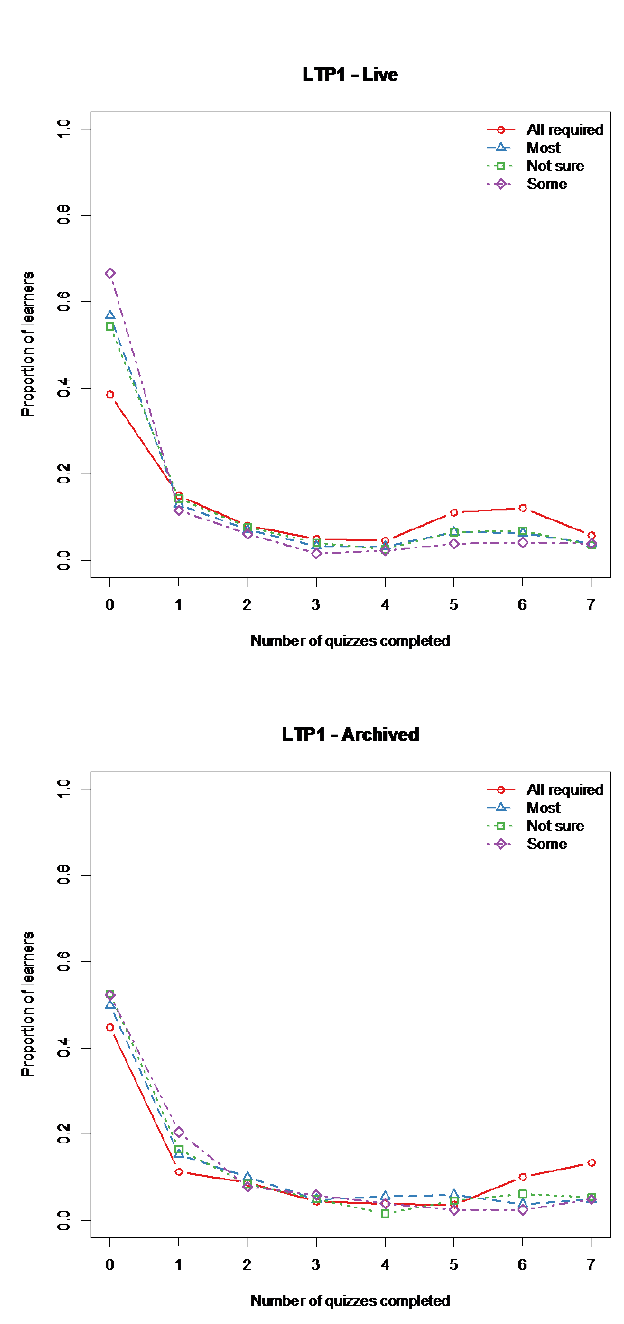
Figure 8. Number of quizzes completed by LTP1 live- and archived-learners, by